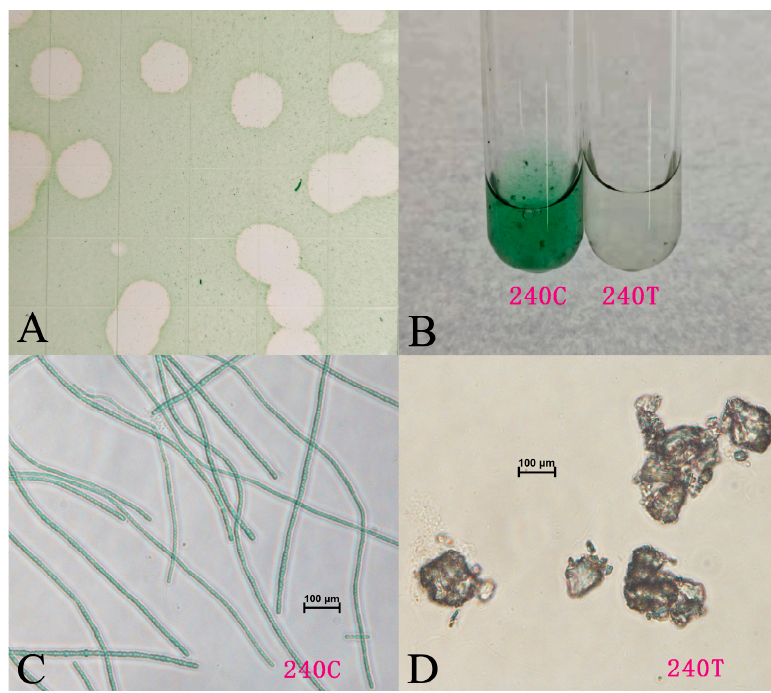
Figure 1. Normal and microscopic pictures of L. boryana FACHB-240 cultures: ( A ) plaques developed by Lbo240-yong1 on the FACHB-240 lawn; ( B ) picture of a FACHB-240 culture (left) and of a FACHB-240 culture infected with Lbo240-yong1 (right); ( C ) microscopic picture of a normal FACHB-240 culture; ( D ) microscopic picture of a FACHB-240 culture infected with Lbo240-yong1.